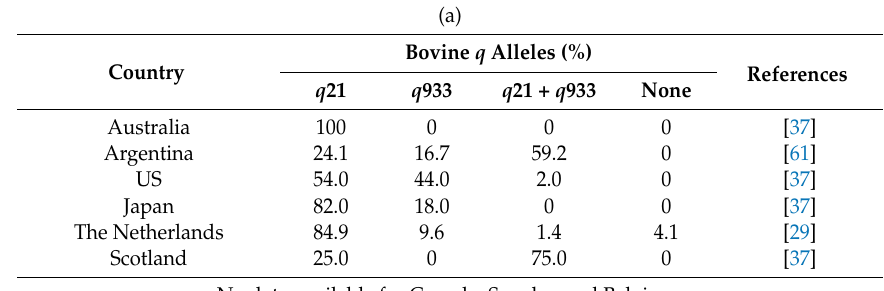
Table 5. Values (or range of values from different sources) of q allele frequencies in (a) bovine and (b) human E. coli O157 strains isolated from different